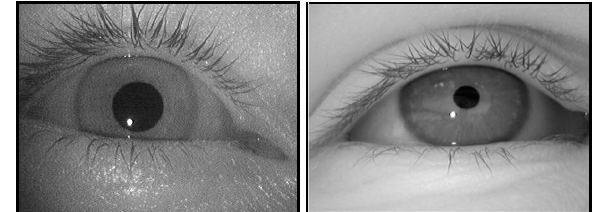
Figure 10. Clear images of the pupil and corneal reflection, captured from a wearable eye-tracking system indoors (left) and outdoors (right).